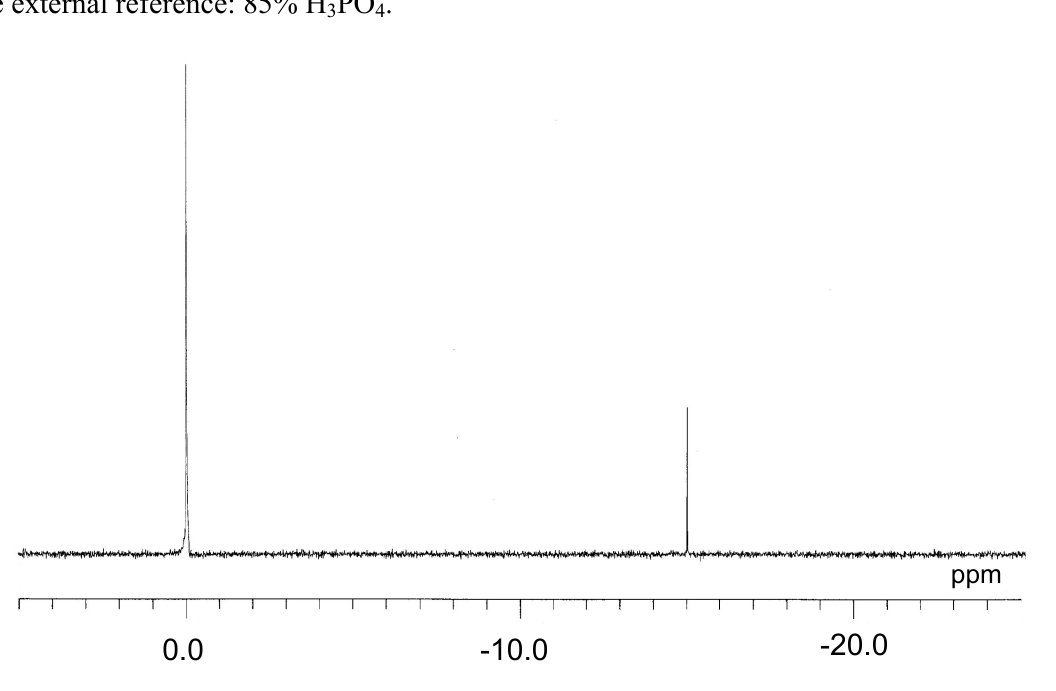
Figure 3. 31 P-NMR spectra in DMSO- d the external reference: 85% H